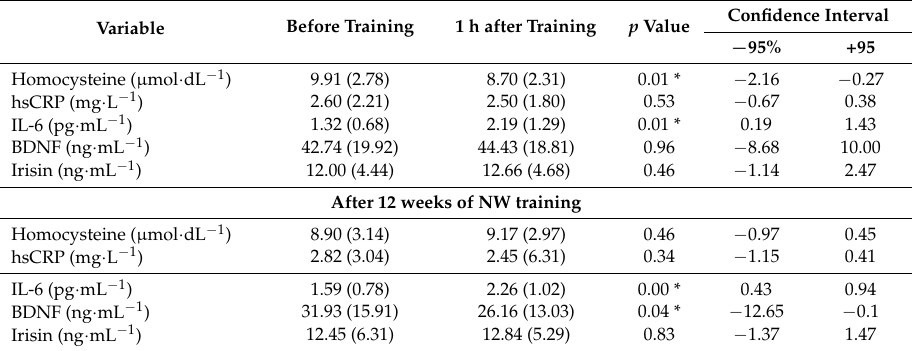
The effect of the first and last single training session of Nordic Walking on immunological response. Variable Before Training 1 h after Training p